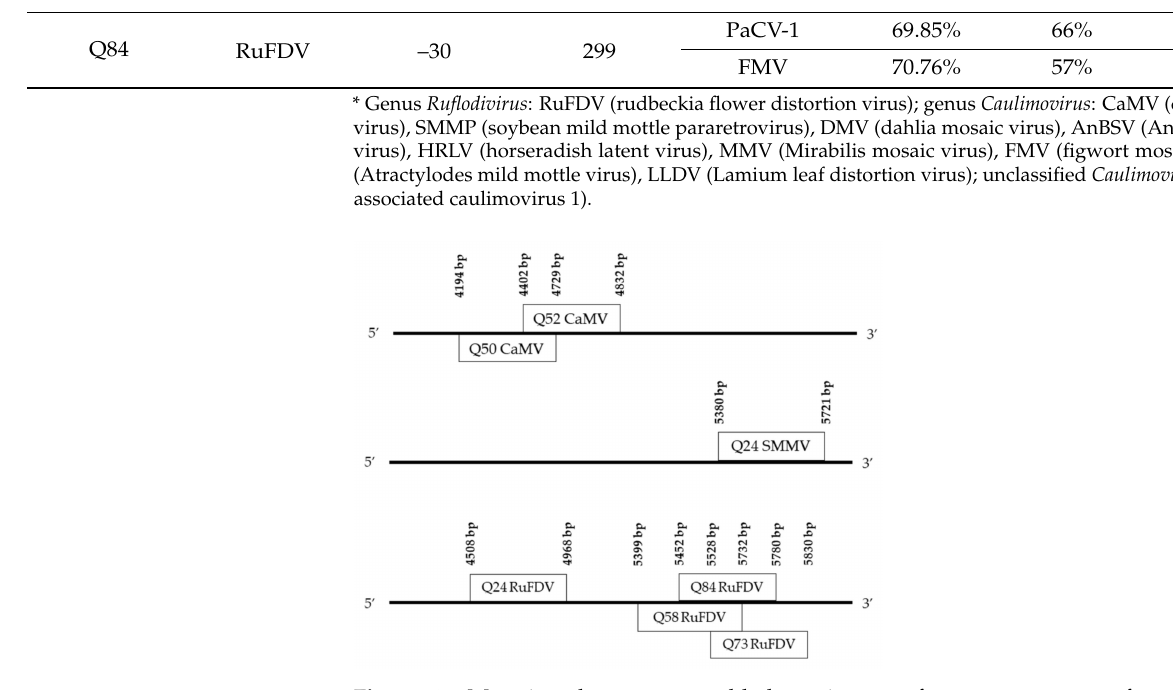
Figure 4. Mapping de novo assembled contigs to reference sequences of cauliflower